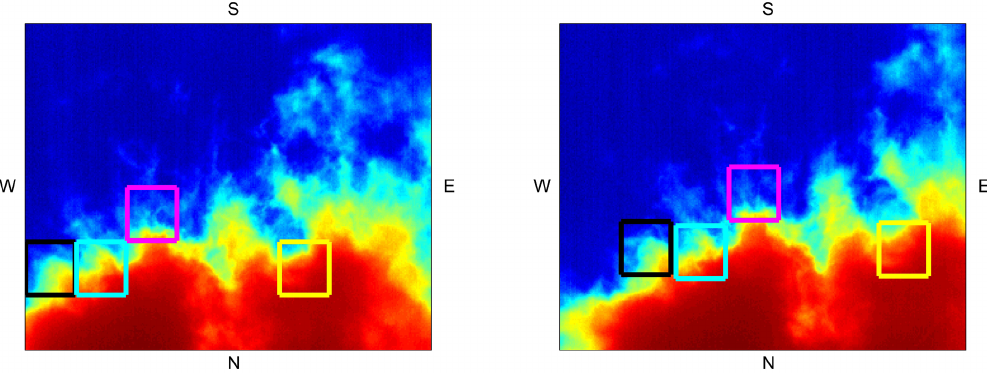
Fig. 4. Automatic detection of cloud patches movement. 40 × 40 pixels blocks with high standard deviation values on the left image are tracked using spatial correlation on the right image. Blocks with matching colors represent the same region. Since our sensors were turned northward prior to the image acquisition, we can mark directions on the images. This will be used later to calculate the wind direction of the air layer in which these clouds are